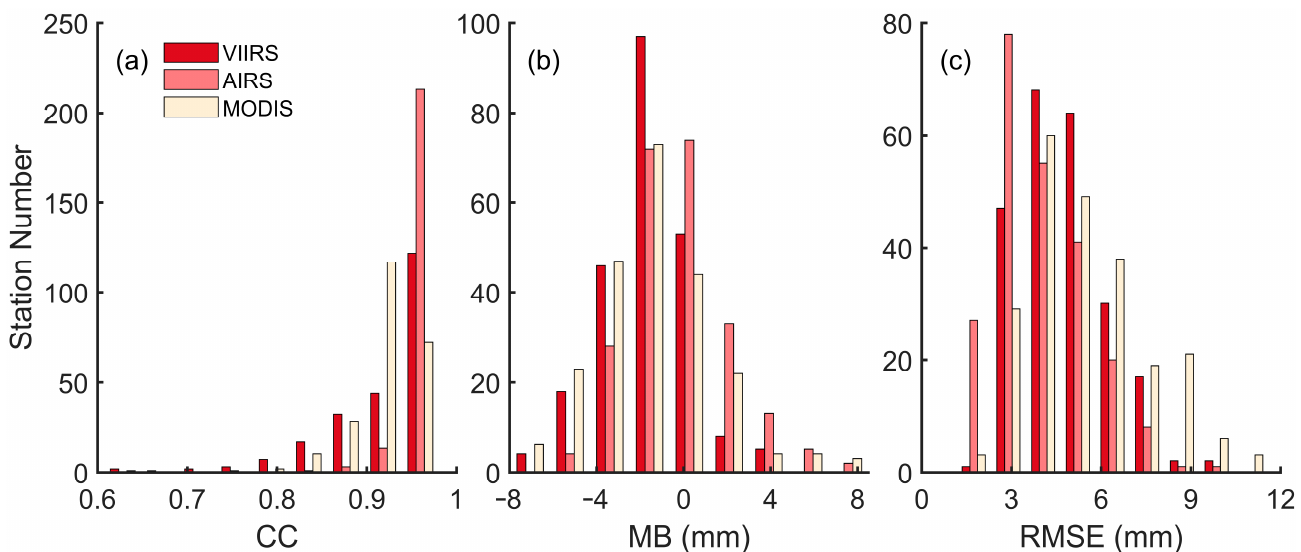
Figure 4. Histograms of the CC ( a ), MB ( b ), and RMSE ( c ) of the PWV data derived from the remotely sensed water vapor products compared with the GPS-PWV at 231 GNSS stations in mainland China.